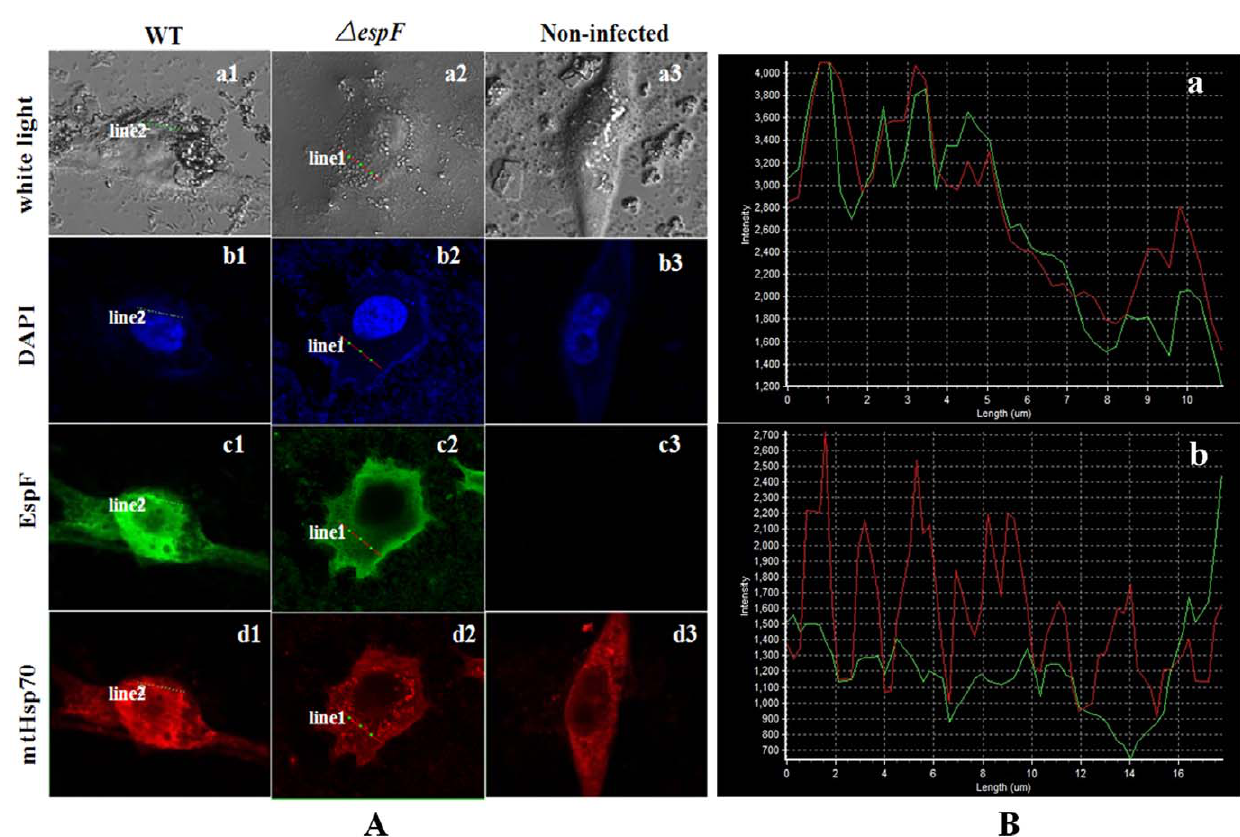
Figure 3. The EHEC effector protein EspF targets the mitochondria post infection. (A) Confocal laser scanning microscopy of Lovo cells infected with EHEC O157:H7. Confocal through the mitochondria of cells: EHEC O157:H7 WT group, D espF group and control group. (a1–a3): the observation under white light based on confocal microscopy. (b1–b3): blue fluorescence signal from the DAPI stained nucleolar region. (c1–c3): green fluorescence signal from the FITC stained EspF protein. (d1–d3): red fluorescence signal from the Rhodamine stained mitochondria heat shock protein 70 (mtHsp70). (B) Red curve enclosed the fluorescent signal of rhodamine stained mtHsp70. Green curve revealed the fluorescent signal of FITC stained EspF protein. (a): curve of WT group. (b): curve of D espF group.